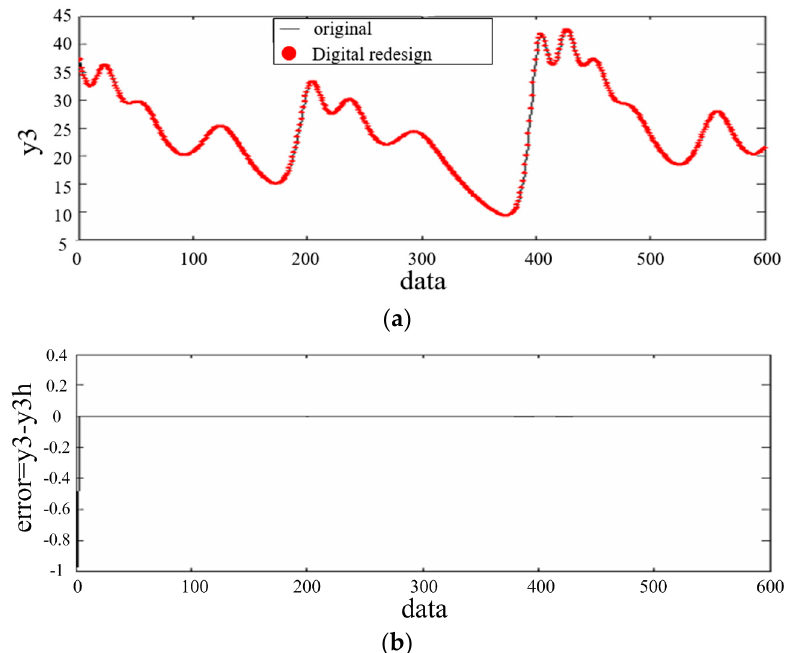
Figure 9. ( a ) Trajectories of y 3 ( t ) and ˆ y 3 ( t ) ; ( b ) Data of output error (cid:101) y 3 ( t )